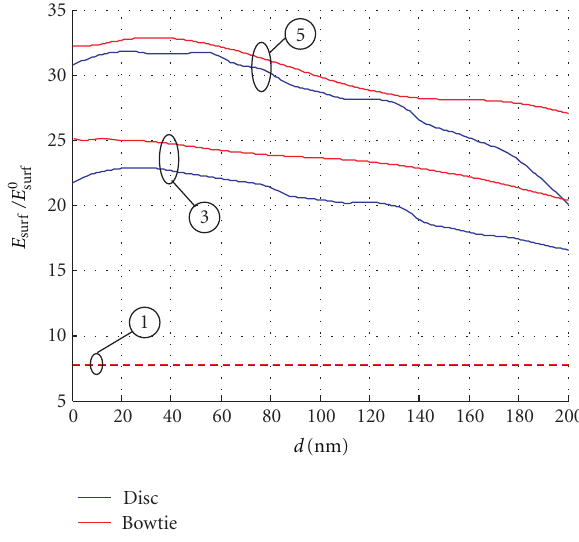
Figure 5: Enhancement ratio for the multiple (3 and 5) dimer configurations compared with a single dimer. In particular, the disc dimer case (blue line) and the bowtie case (red line) are plotted as a function of the interelement distance d , for a radius r = 40nm and gap = 5nm. The disc dimer and the bowtie are both oriented along the dipole source (see Figure